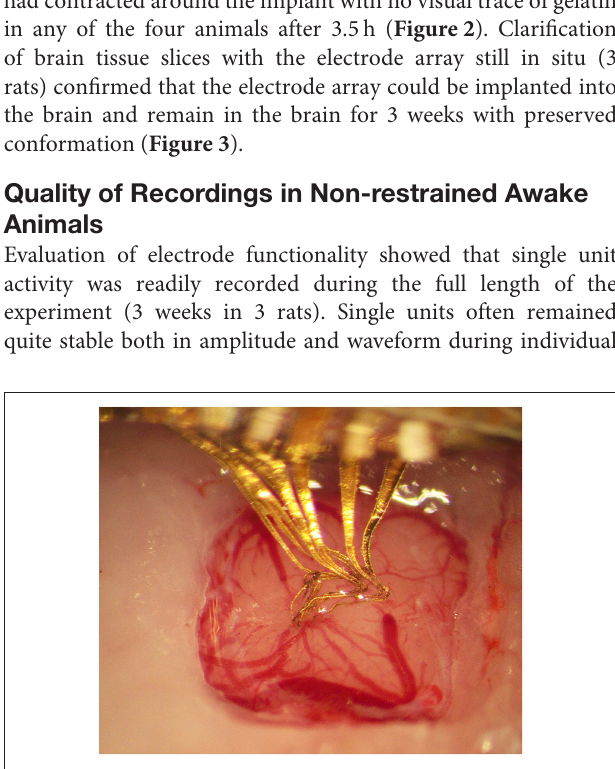
FIGURE 2 | Photograph taken 3.5h after implantation of the gelatin embedded electrode, showing that the gelatin has dissolved and the brain surface contracted around the electrode array.